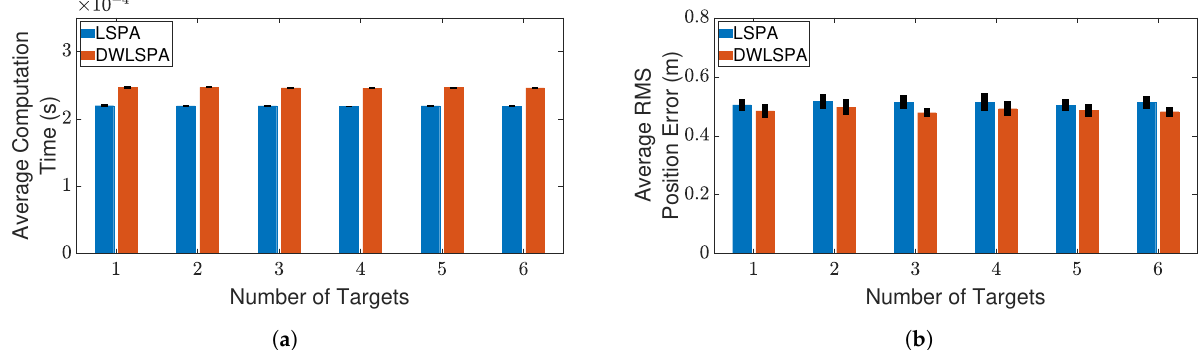
Figure 10. Tracking multiple crossing targets using LSPA and DWLSPA with clutter density λ = 1 × 10 − 4 /m 2 . ( a ) Av- erage computation time for obtaining association probabilities; ( b ) average RMS position error. Error bars indicate 95% confidence